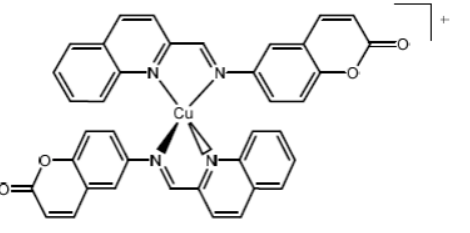
Figure 1. Chemistry structure of copper (I) complex [Cu(NN 1 ) 2 ]ClO 4 . NN 1 is 6-((quinolin-2- ylmethylene) amine)-2H-chromen-2-one.